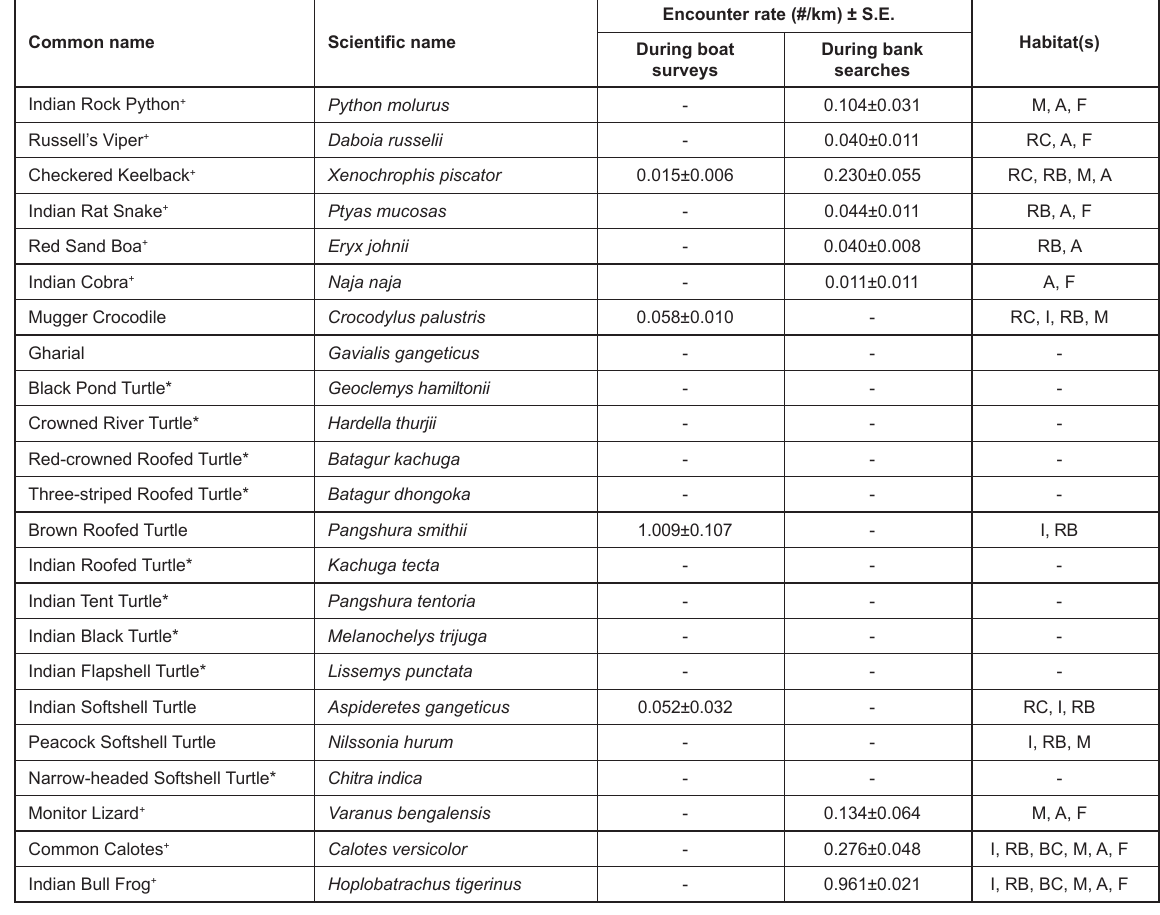
Table 3 List of reptilian species recorded along upper Ganges and its